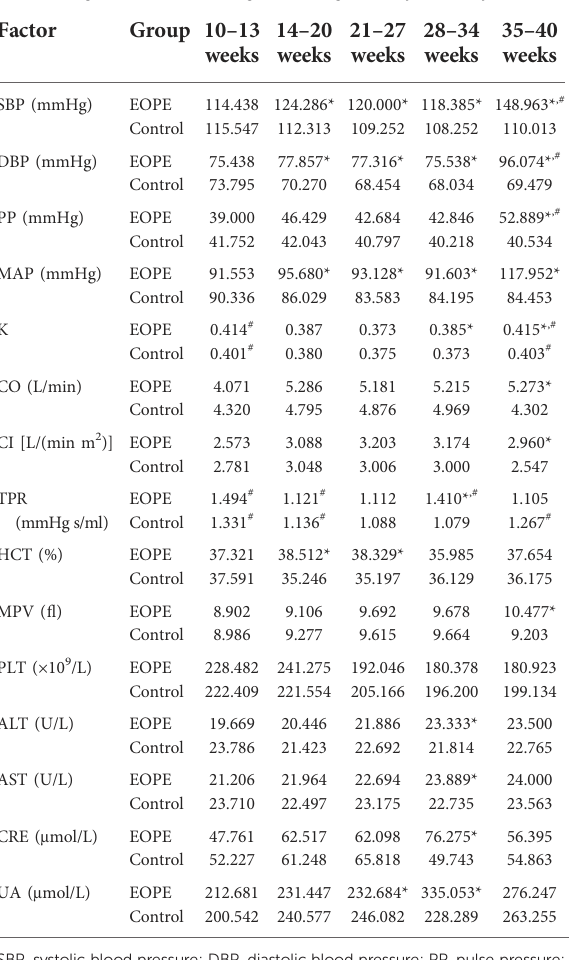
TABLE 9 Dynamic factors analysis of early-onset preeclampsia. TABLE 10 Dynamic factors analysis of late-onset